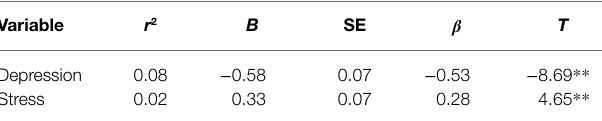
** Correlation is significant at the 0.01 level (2-tailed).